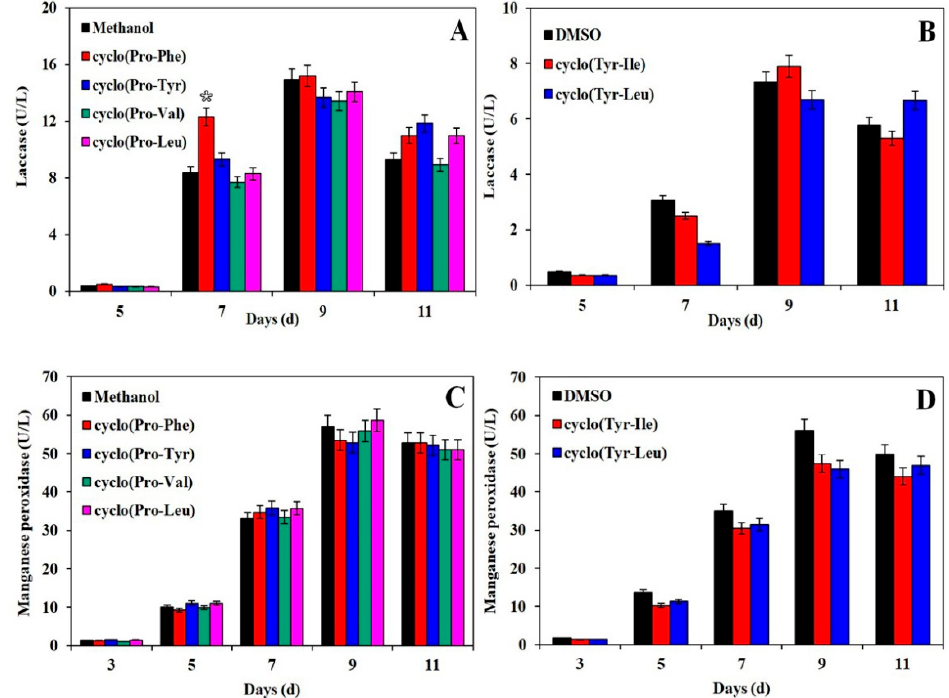
Figure 4. Effects of signal molecules on the activity of lignin-degrading enzymes secreted by Hypsizygus marmoreus. ( A , B ) Effects of signal molecules dissolved in methanol and dimethyl sulfoxide (DMSO) on laccase activity; ( C , D ) effects of signal molecules dissolved in methanol and DMSO on manganese peroxidase activity. All measurements in these experiments were made in triplicate. Bars are significantly ( p < 0.05) different from each other by T-test.